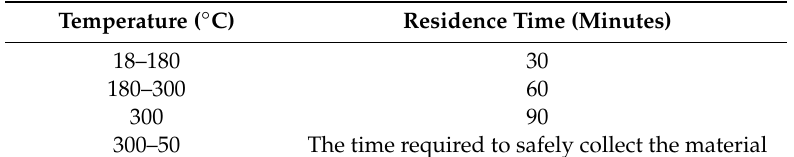
Table 1. Correspondence of the four programmable levels with the di ff erent torrefaction phases, depending on the temperature and residence time.